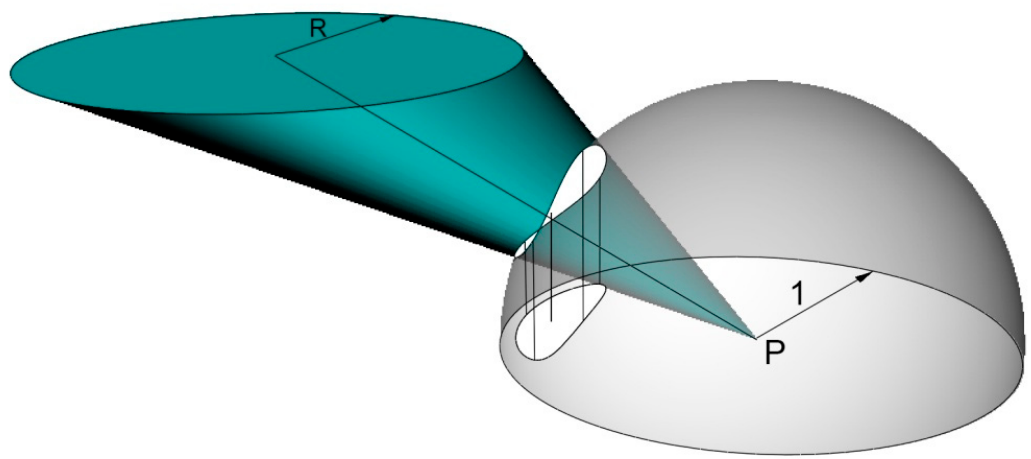
Figure A5. Projection on the horizontal plane of the intersection of an oblique cone and a unit radius sphere.